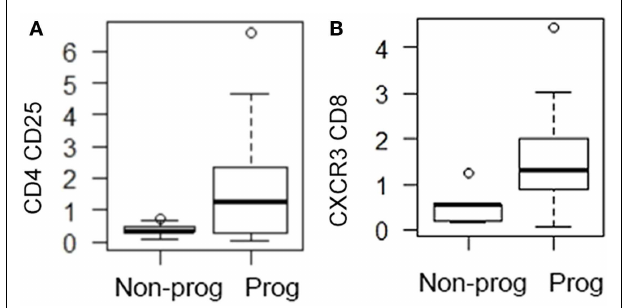
FIGURE 1 | Progressive IPF patients are characterized by higher percentages of CD4 CD25 + and CD8 CXCR3 + cells .The box shows the range of the data from 25th percentile to 75th percentile.The bar in the middle of the box represents the median (50th percentile).The lower and upper whiskers gives the range of the data with each whisker restricted to 1.5 times the interquartile range (which is defined as the upper quartile minus the lower quartile) with circles indicating data outside of this whisker range. (A) CD4 CD25 percentages are graphed; (B) CXCR3 CD8 percentages are graphed.